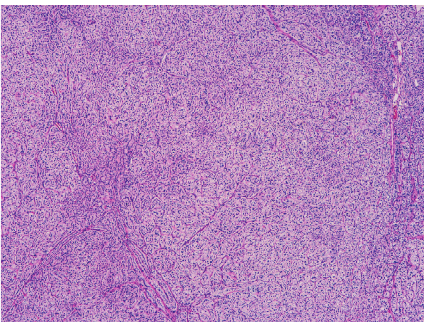
Figure 6: Cerebral CT scan of the index patient.